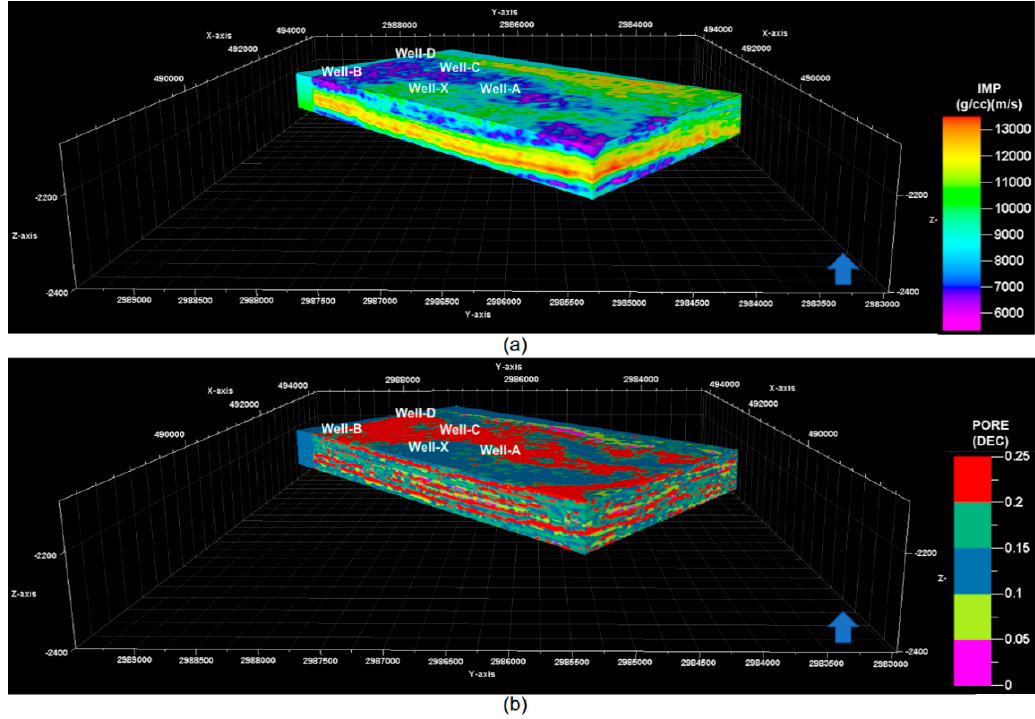
Figure 16. ( a ) 3D AI model, ( b ) seismic inversion of 3D effective porosity models within a speci fi ed time window (2160 to 2280 ms) covering target horizons.